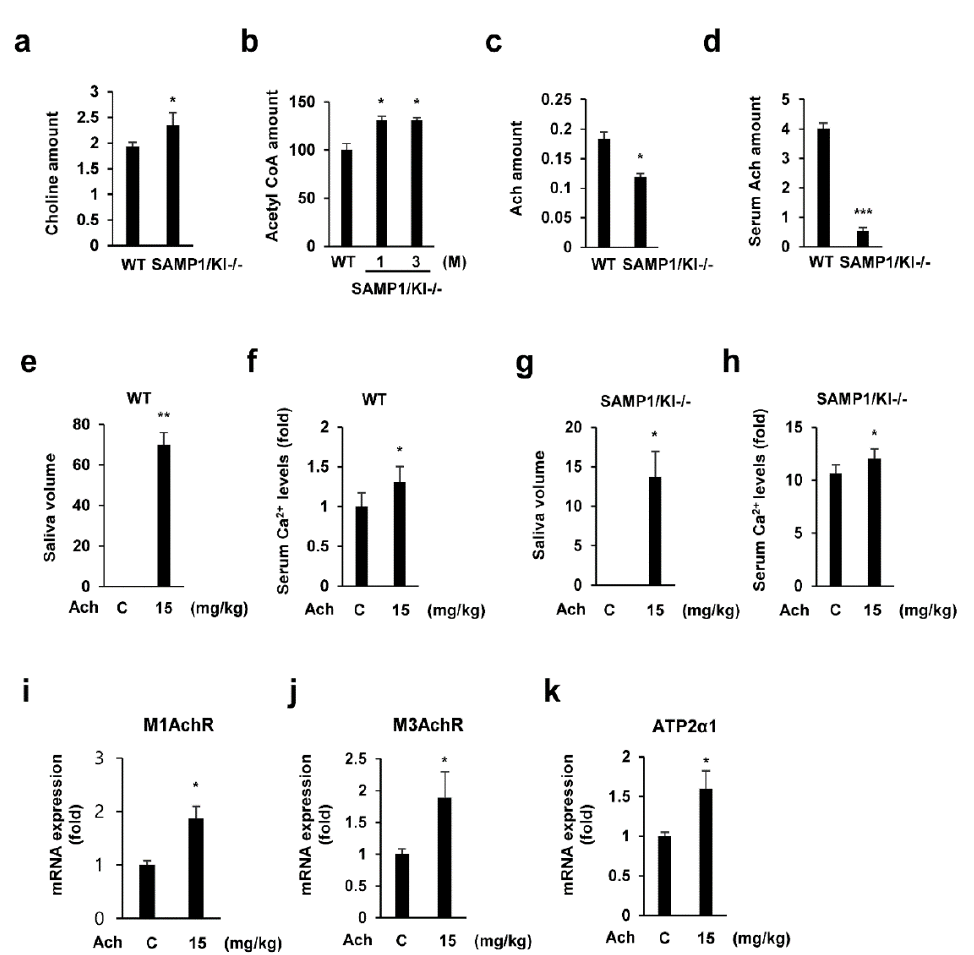
Figure 2. Age-related acetylcholine metabolism alteration and acetylcholine-induced modification in the SAMP1/kl model. ( a – d ) The concentration of acetylcholine-related metabolites in salivary gland tissues and serum. ( e – h ) Impact of acetylcholine treatment on salivation in SAMP1/kl +/+ and SAMP1/kl -/- mice. ( i – k ) Acetylcholine injection induces the expression of several key enzymes involved in saliva secretion. Gene expression was measured by quantitative reverse transcription polymerase chain reaction (qRT-PCR). Data are presented as the mean ± standard deviation (SD). * p < 0.05, ** p < 0.01, *** p < 0.001. Data were compared by analysis of variance (ANOVA) with Bonferroni’s multiple comparisons test, in which each group was compared to the mean of the control.